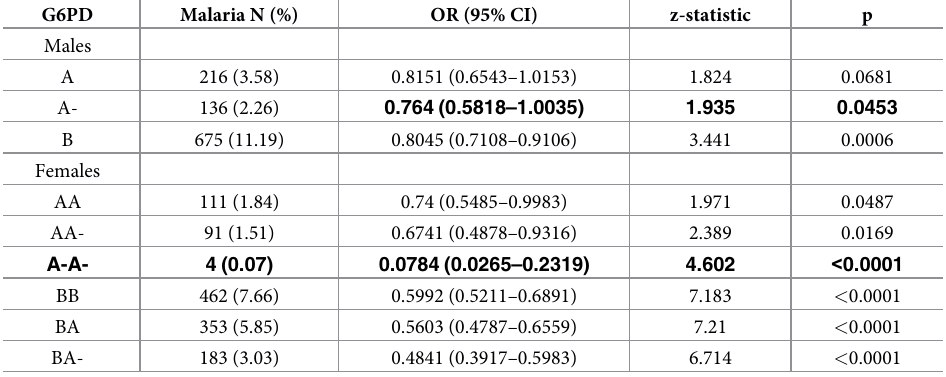
dium falciparum infection relative to the females with the AA, AA- A-A- variants, whilst males with the B genotype had higher infection prevalence relative to those with the A, & A- variants. Table 4. The odds of detecting malaria microscopically among the glucose-6-phosphate dehydrogenase genotypic variants.